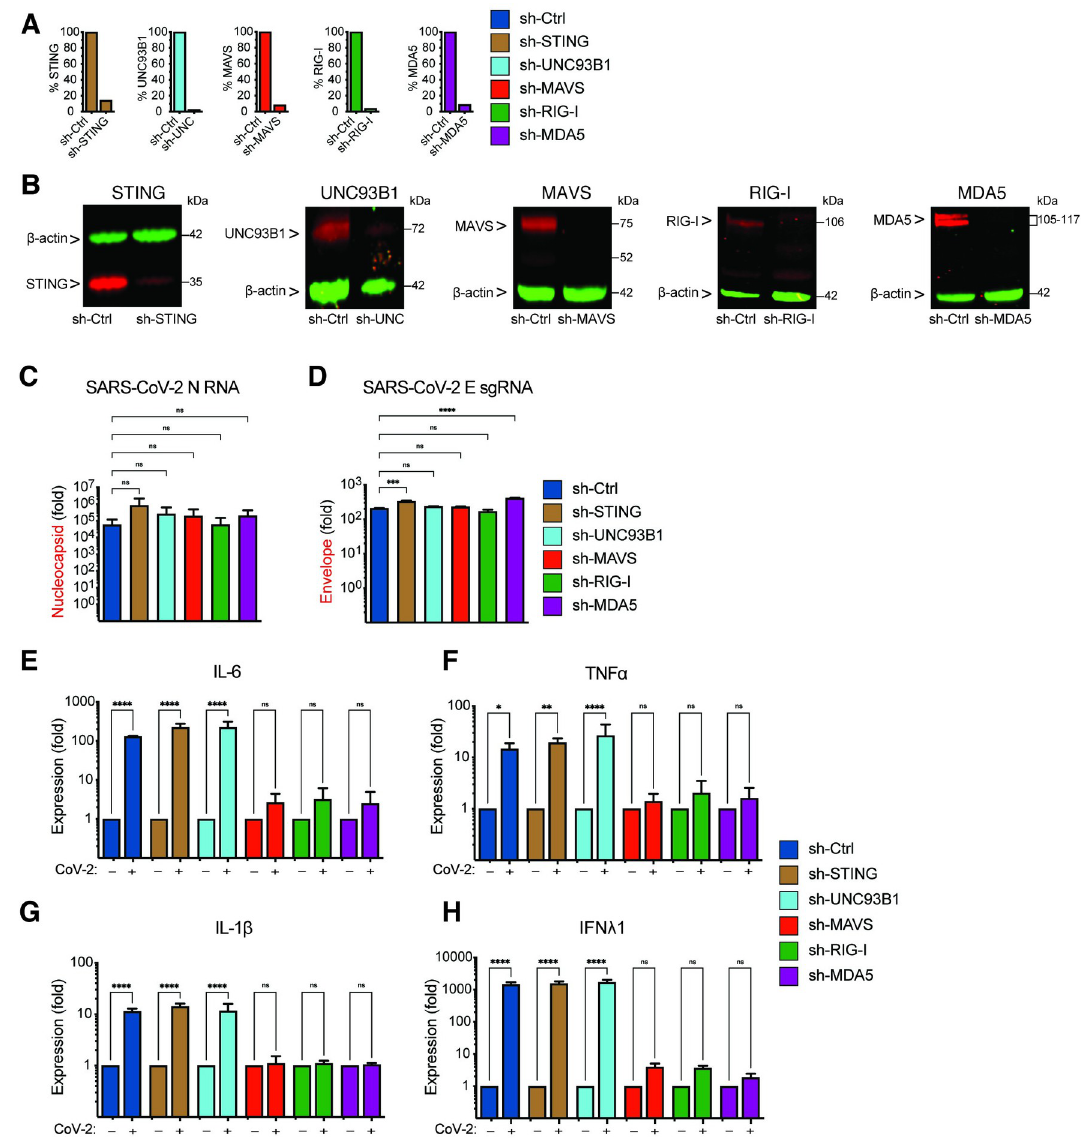
Fig 8. Viral RNA sensing by RIG-I and MDA5 is required for SARS-CoV-2 induced innate immune responses in macrophages. ( A - B ) CD169-expressing THP1 monocytes were transduced with lentiviral vectors expressing shRNA against non-specific control (scramble), or specific shRNA sequences against STING, UNC93B1, MAVS, RIG-I, and MDA5. Knockdown of host proteins targeted by shRNAs compared to scramble analyzed by RT-qPCR ( A ), and immune blotting ( B ). ( C - H ) Total RNA from CD169 + THP1/PMA macrophages infected with SARS-CoV-2 (MOI = 1, 24 hpi) was analyzed by RT-qPCR for nucleocapsid (gRNA) ( C ), envelope (sgRNA, D ), and pro-inflammatory cytokines/ISGs, IL6, TNF α , IL-1 β and IFN λ 1 ( E - F ), normalized to mock-infected controls for each group. Each knockdown is represented by different colors as in A . The means ± SEM from 3 independent experiments are shown, and significant differences were determined by one-way ANOVA followed by the Dunnett’s post-test comparing to scramble THP1 ( C - D ), or by two-way ANOVA followed by Bonferroni post-test comparing Mock to SARS-CoV-2 infected in each group ( E - H ). P -values: � < 0.1; �� < 0.01; ��� < 0.001; ���� < 0.0001); ns: not significant. CD169, ACE2, or both CD169 and ACE2 were transduced with lentiviral vectors expressing scramble shRNAs (control) or MAVS-specific shRNAs, which led to robust knock-down of MAVS protein expression in all cell lines ( Fig 9A ). While MAVS depletion did not affect sub- sequent SARS-CoV-2 infection of CD169 + , ACE2 + or CD169 + /ACE2 + THP1/PMA cells, as